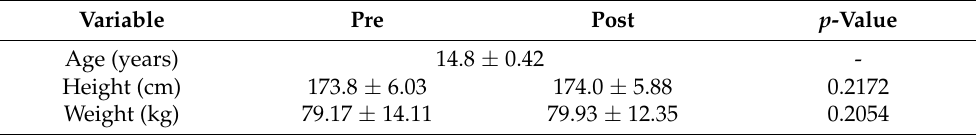
Table 2. Participant anthropometric measurements.